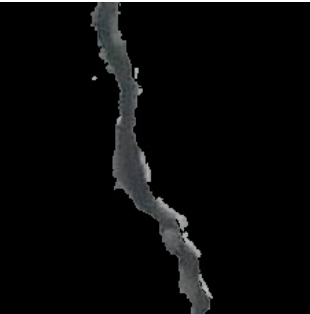
Figure 4. Result of foreground extraction by GrabCut algorithm from Figure 3b.